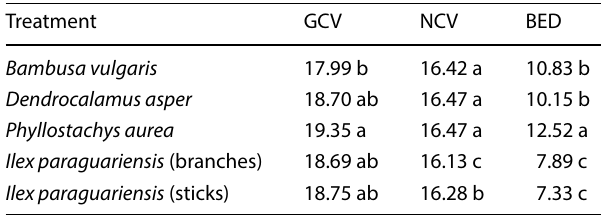
Table 3 Average values of the energetic properties of the different biomasses